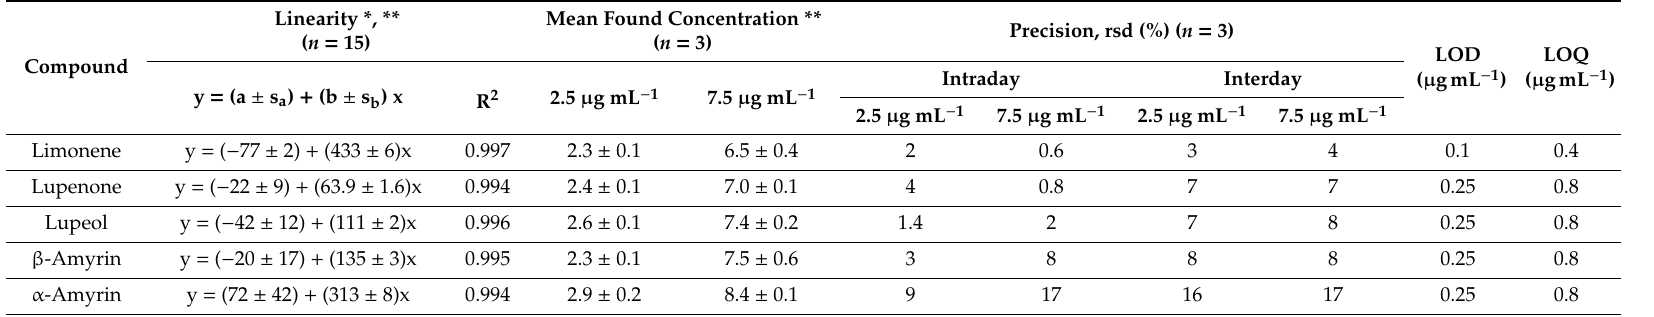
Table 1. Analytical parameters of the proposed